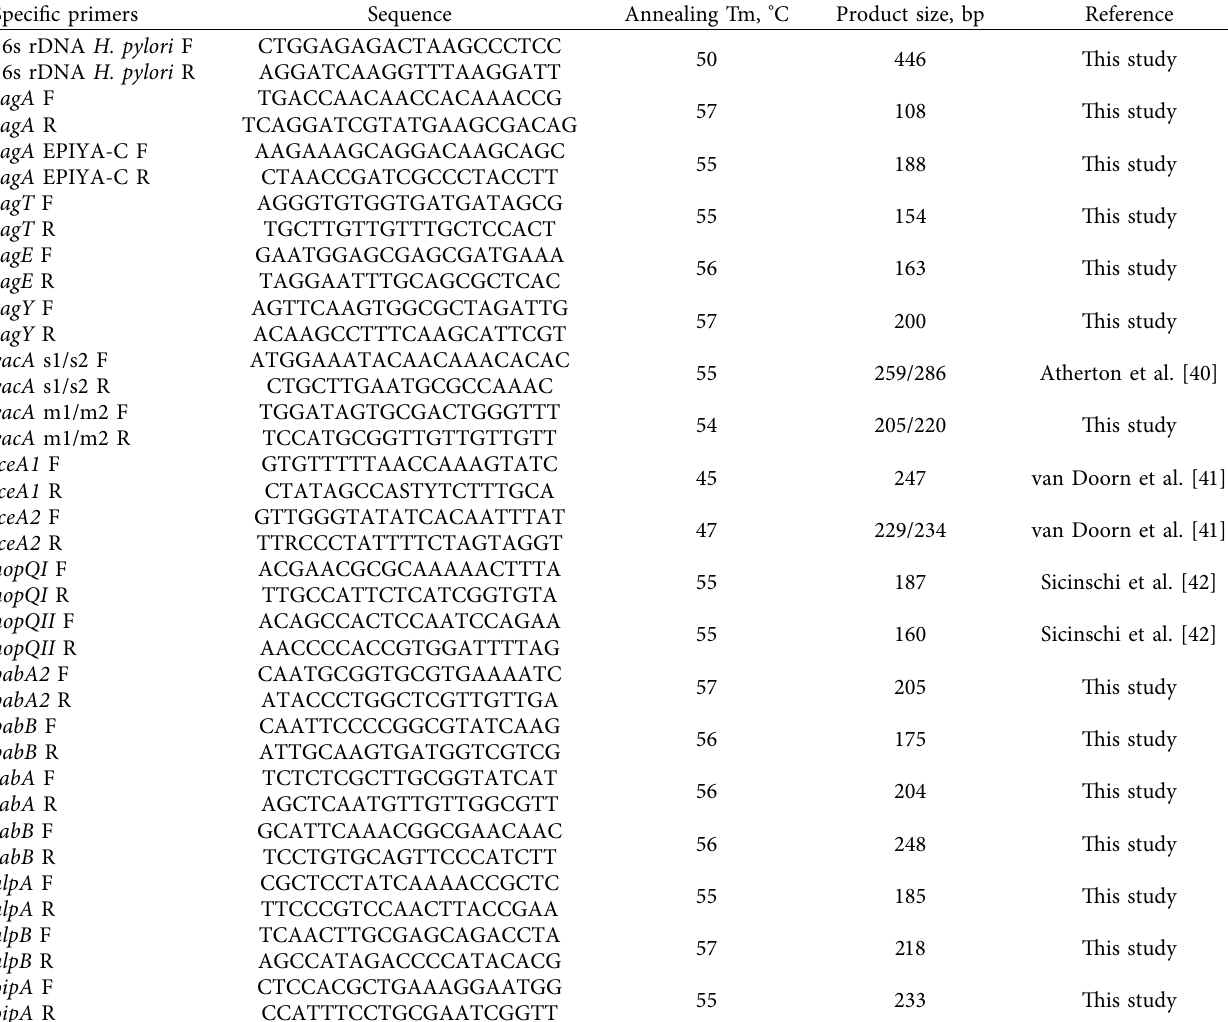
Table 1: Primers used in this